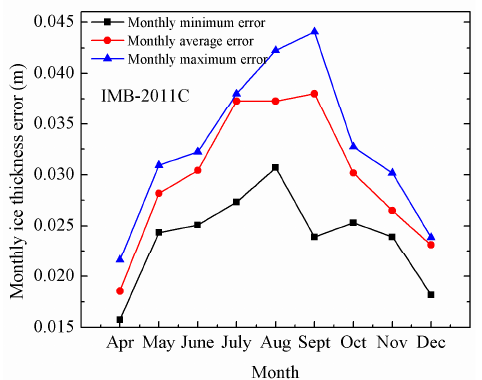
Figure 9. The monthly maximum error (blue line), minimum error (black line) and average error (red line) of sea ice thickness derived from the measurements of IMB-2011C, respectively.